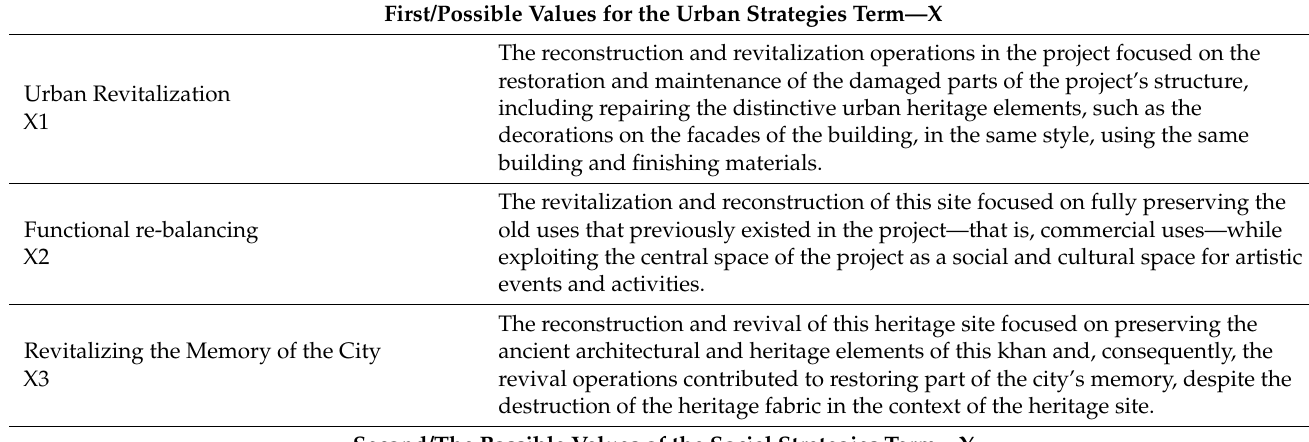
Table 3. Specialized description form for measuring the verification values of the variables of strategies for reviving urban heritage after war. Project